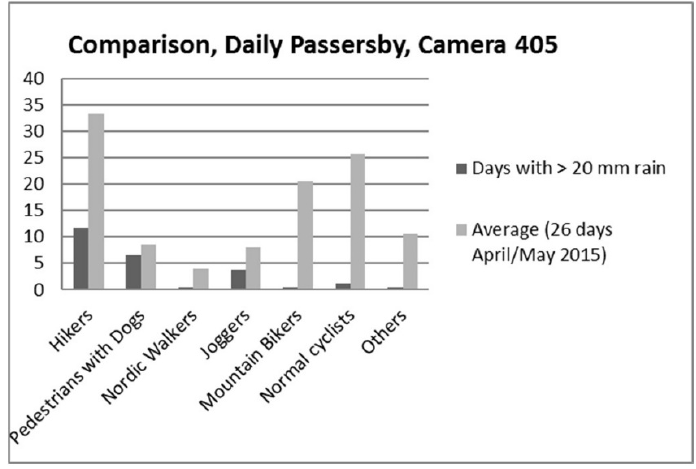
Figure 7. Comparison of passersby at the camera sites on “average days” and on “rainy days” (>20 mm of rain per day) at the eastern entrance of the World Forest, Freising, Bavaria, Germany.